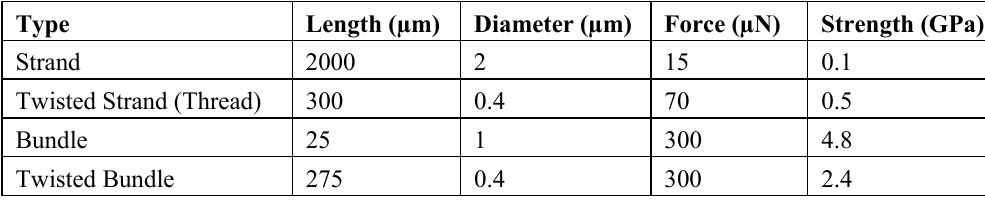
Table 1. Measured force and approximated strength for CNT samples based on the CS area of the